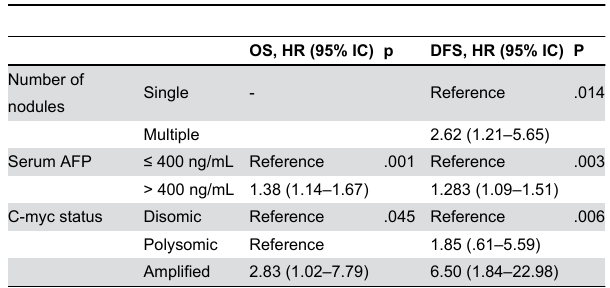
Table 4. Multivariate analysis for overall survival (OS) and disease free survival (DFS).